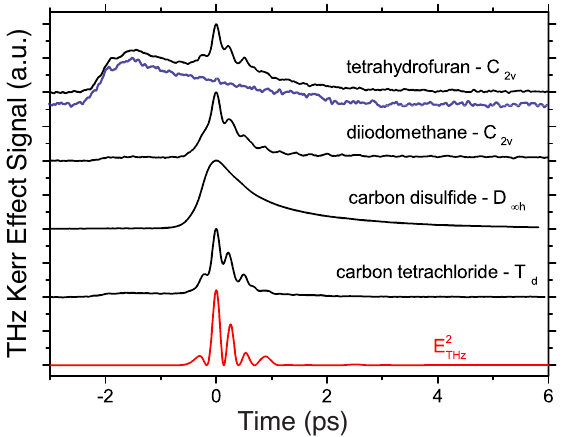
Figure 14. Measured THz Kerr-effect signals, generated by a terahertz–terahertz–Raman pulse sequence, of various liquids (black curves) [187]. Vibrational coherences are visible as oscillations in the measured signal. The bottom red trace is the square of the applied THz electric field and the blue trace below the tetrahydrofuran data shows the empty cuvette background response. Reprinted from Ref. [187] with permission from AIP